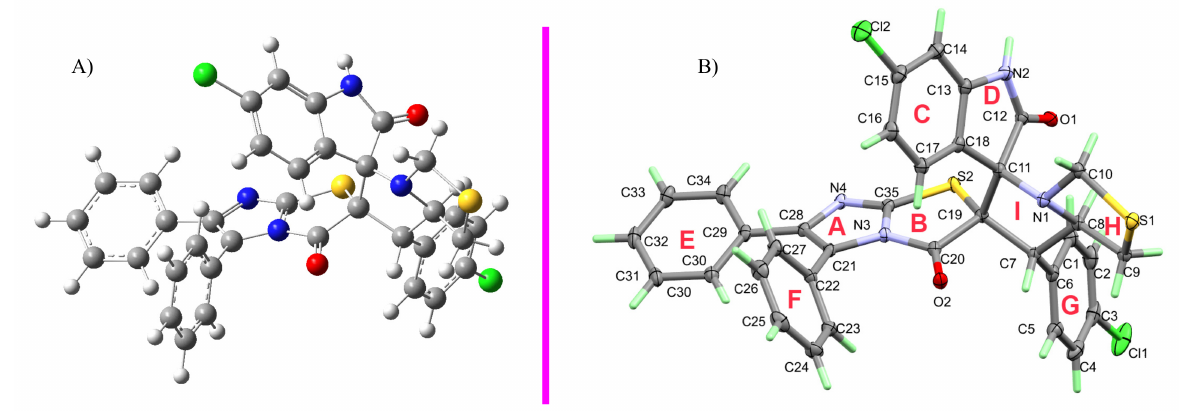
Figure 2. ( A ) AM1 semiempirical optimization ( 4 − ortho-endo ); ( B ) X − ray structure of 4 . Table 1. Crystal Data of compound 4